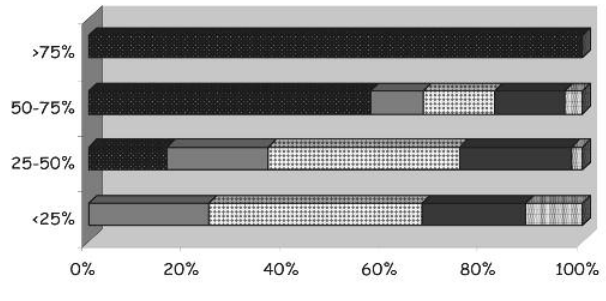
Figure 2. Distribution of farmer states in function of the income rate from agricultural production, in function (%) of the valid answers,